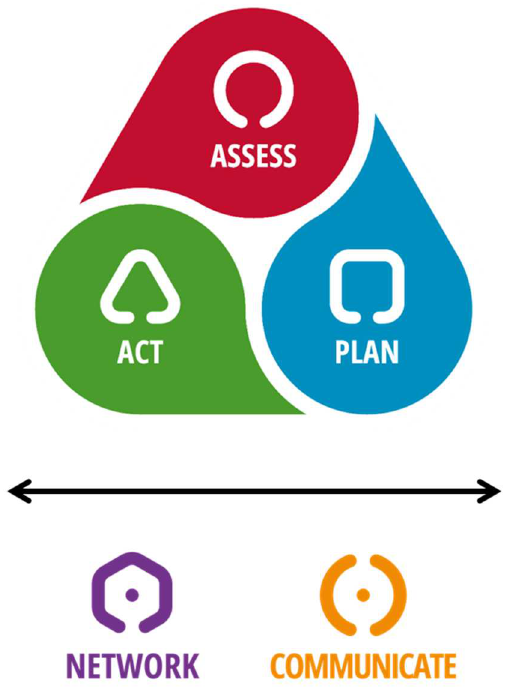
Figure 2. The IUCN SSC Species Conservation Cycle. Reproduced from Rodríguez, et al. [19].